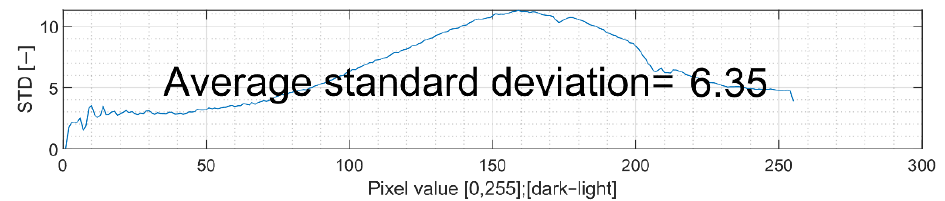
Figure 13. Standard deviation characteristic of matched graphic calculations.